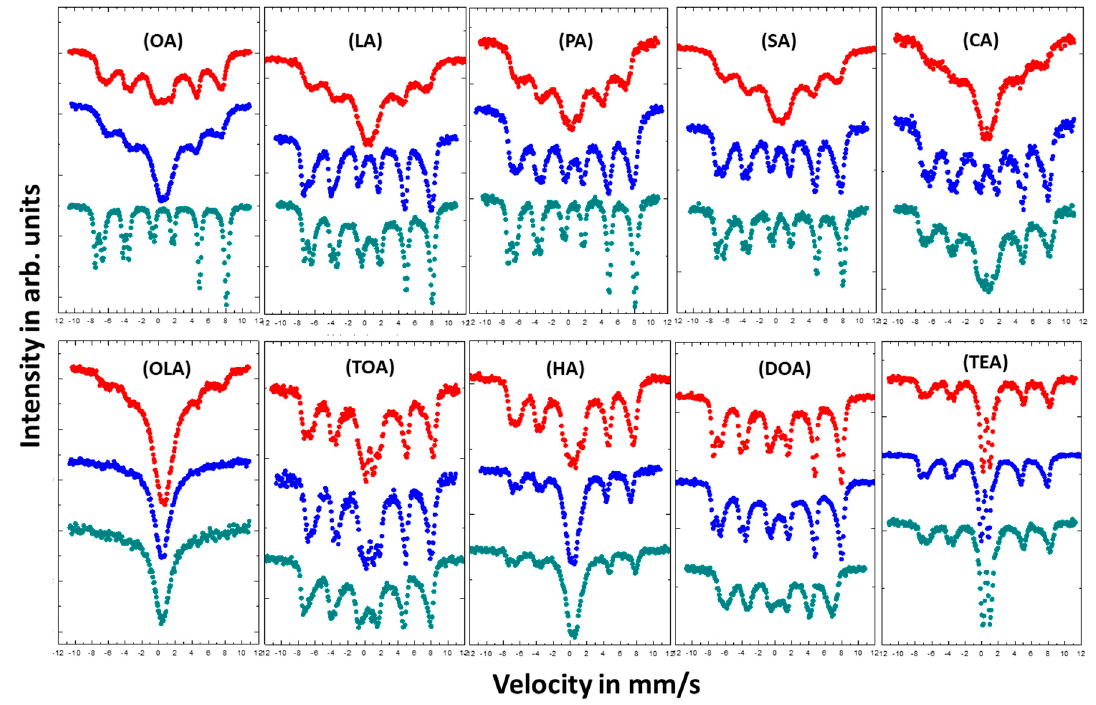
Figure 5. Room temperature (RT) Mössbauer spectra of magnetite nanoparticles with di ff erent coatings. Color of the spectra determines the amount of added surfactant: Red—4 mmol; blue—8 mmol; and green—16 mmol.